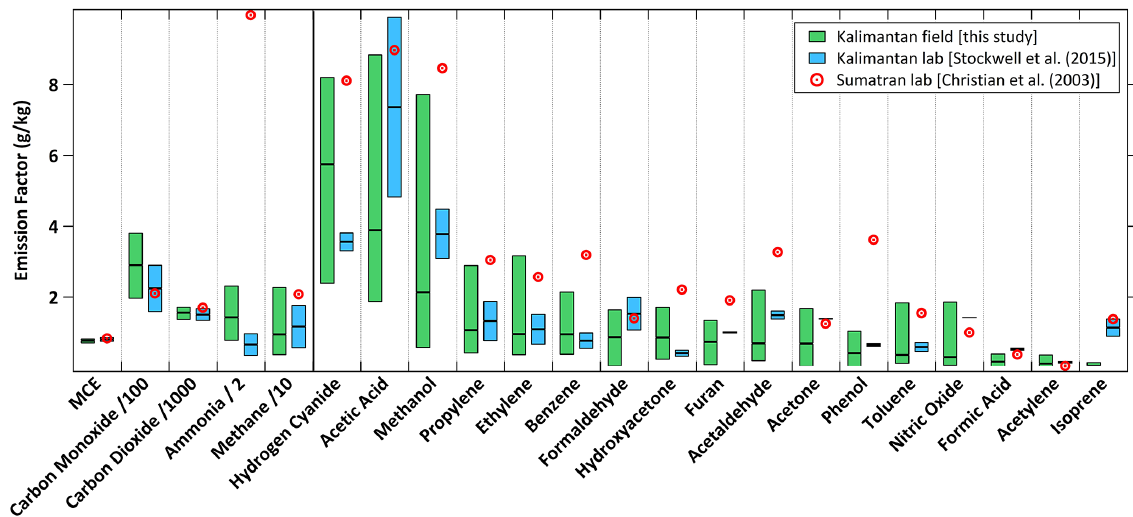
Figure 7. Study overlap (minimum, maximum, and average) including field Kalimantan samples from this study (green), Kalimantan labo- ratory stack burns (blue; Stockwell et al., 2014, 2015), and a single laboratory burn of Sumatran peat (red; Christian et al.,